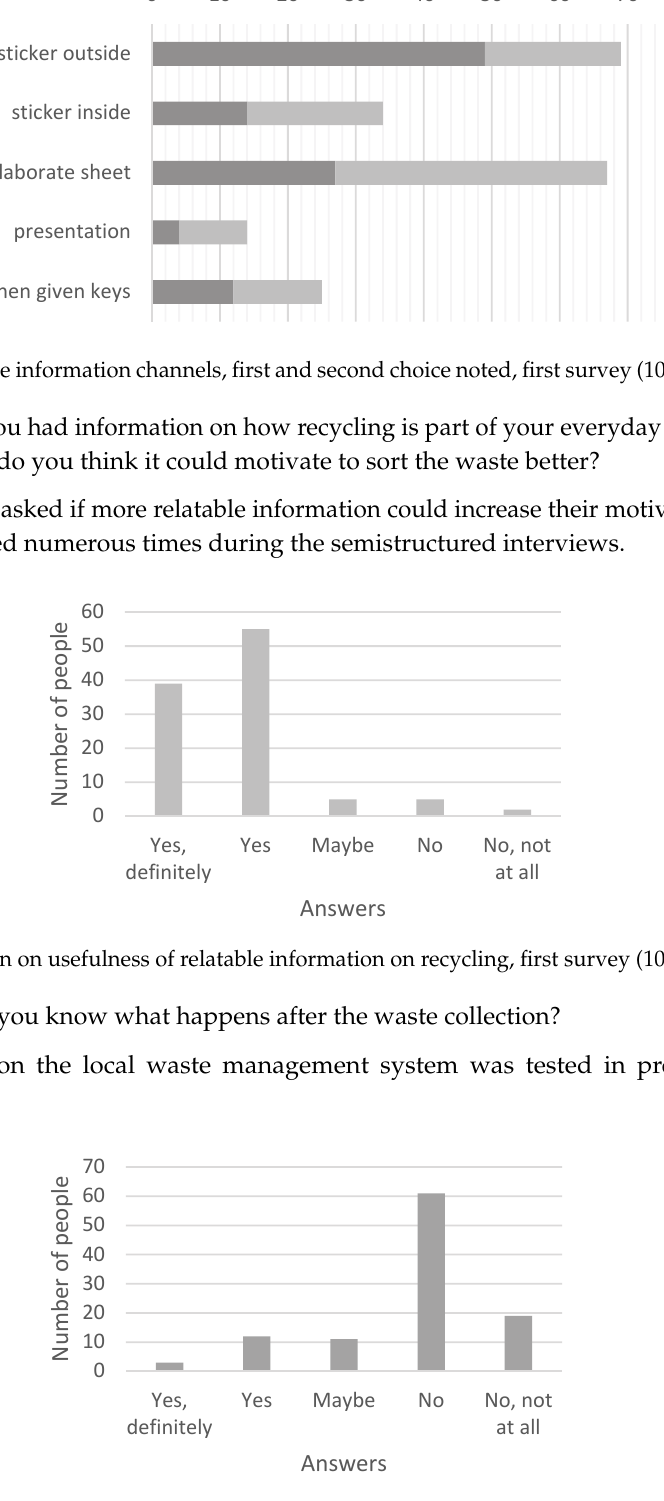
Figure A14. Perceived knowledge on postcollection recycling in Borås, first survey (106 individuals).